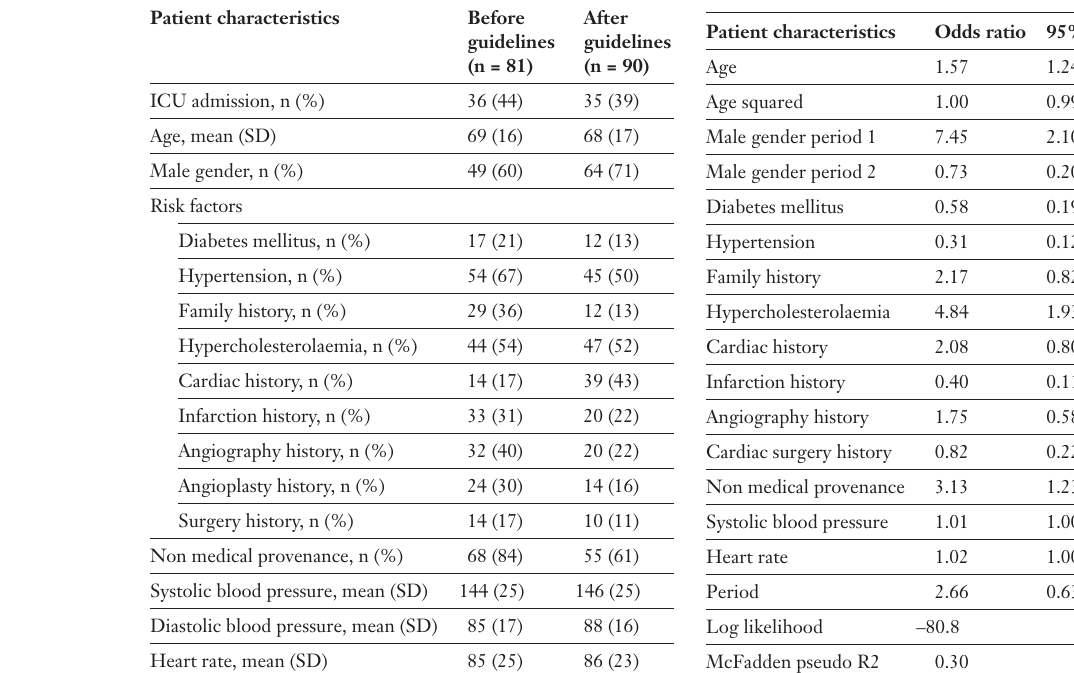
ACS high and very high risk patients’ characteristics. Impact of patients’ characteristics and study period on probability of ICU admission (logistic